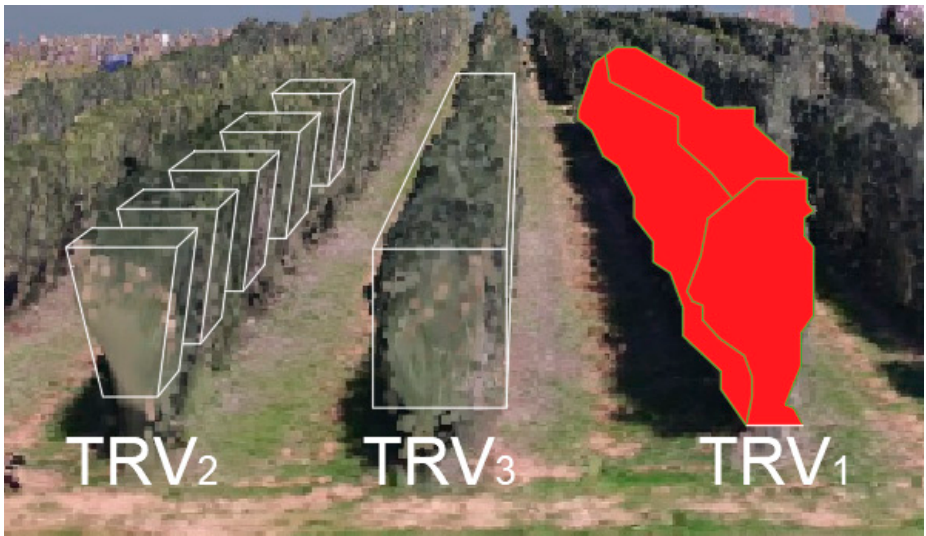
Figure 8. Different volumetric representations of tree crowns in the super-high-density olive orchard following three different TRV estimation methods (TRV 1 , TRV 2 , and TRV 3 ).